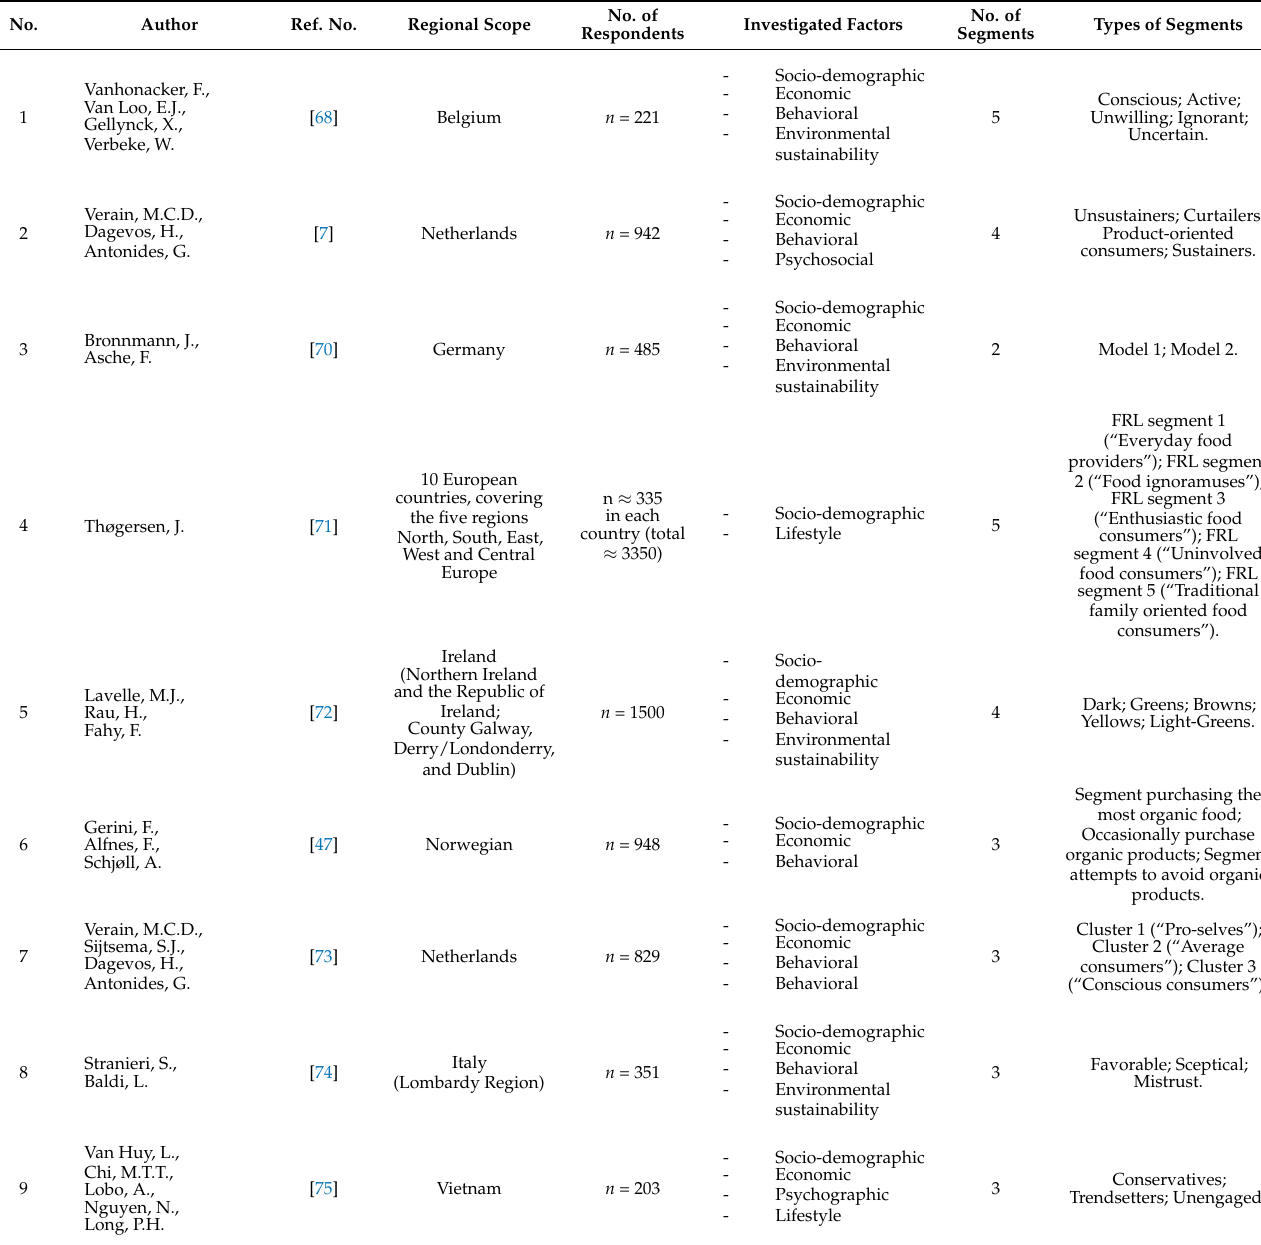
Table 1. Overview of the 27 selected